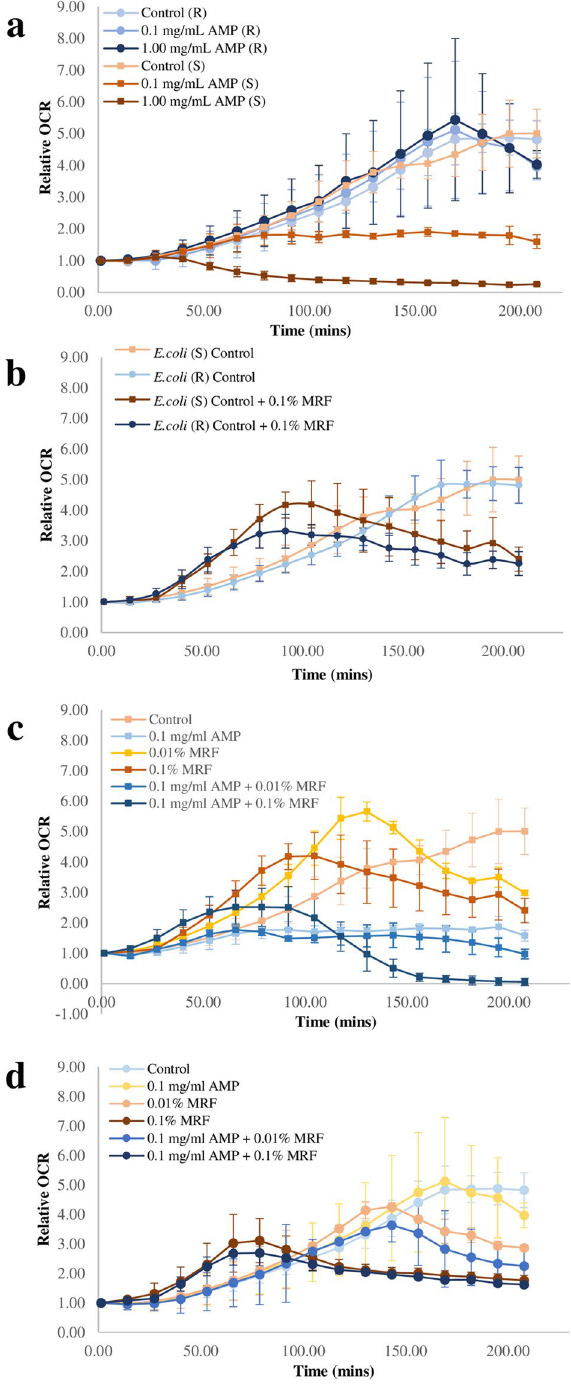
Figure 3. Real time comparison of changes in relative OCR (pmol/min) of antibiotic susceptible and resistant E. coli ; (a) relative OCR (pmol/min) of antibiotic susceptible and resistant E. coli in the presence and absence of ampicillin; (b) relative OCR (pmol/min) of antibiotic susceptible and resistant E. coli with and without MRF supplementation (0.1% (w/v)); (c) relative OCR (pmol/min) of antibiotic susceptible E. coli with and without MRF supplementation in the presence and absence of ampicillin treatment; (d) relative OCR (pmol/min) of antibiotic resistant E. coli with and without MRF supplementation in the presence and absence of ampicillin treatment. All data expressed using mean of triplicate values for each biological replicate (n = 3), standard deviation is represented by error bars. (R), E .coli resistant to ampicillin; (S), E. coli susceptible to